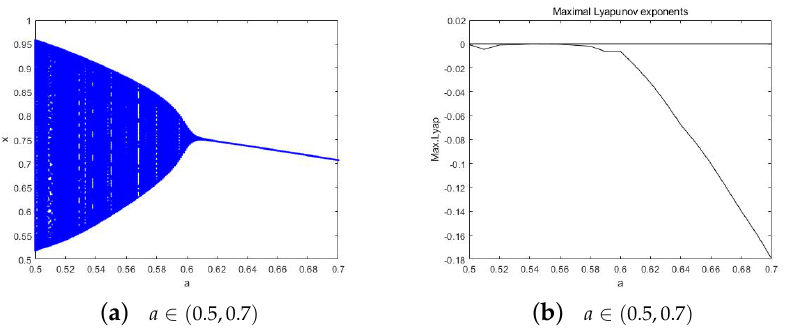
Figure 1. Bifurcation of system (10) in ( a , x ) plane and maximal Lyapunov exponent for b = 1.4.